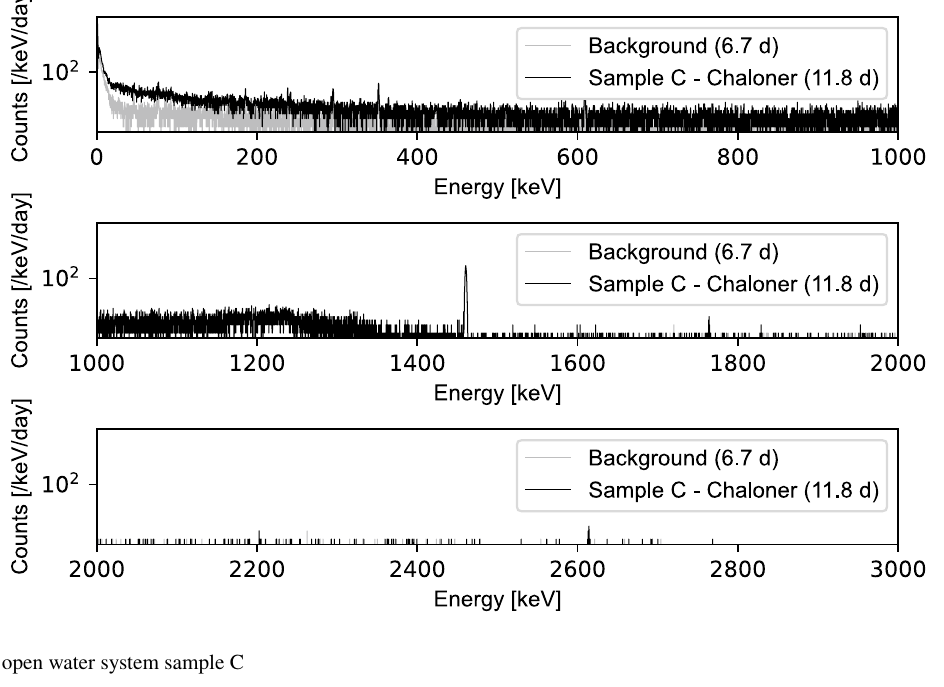
Fig. 9 Spectra of open water system sample